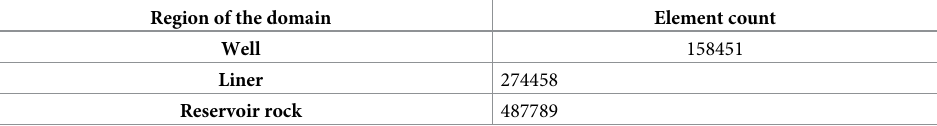
Table 5. Element count per region obtained for the meshing of the domain using unstructured polyhedral elements.